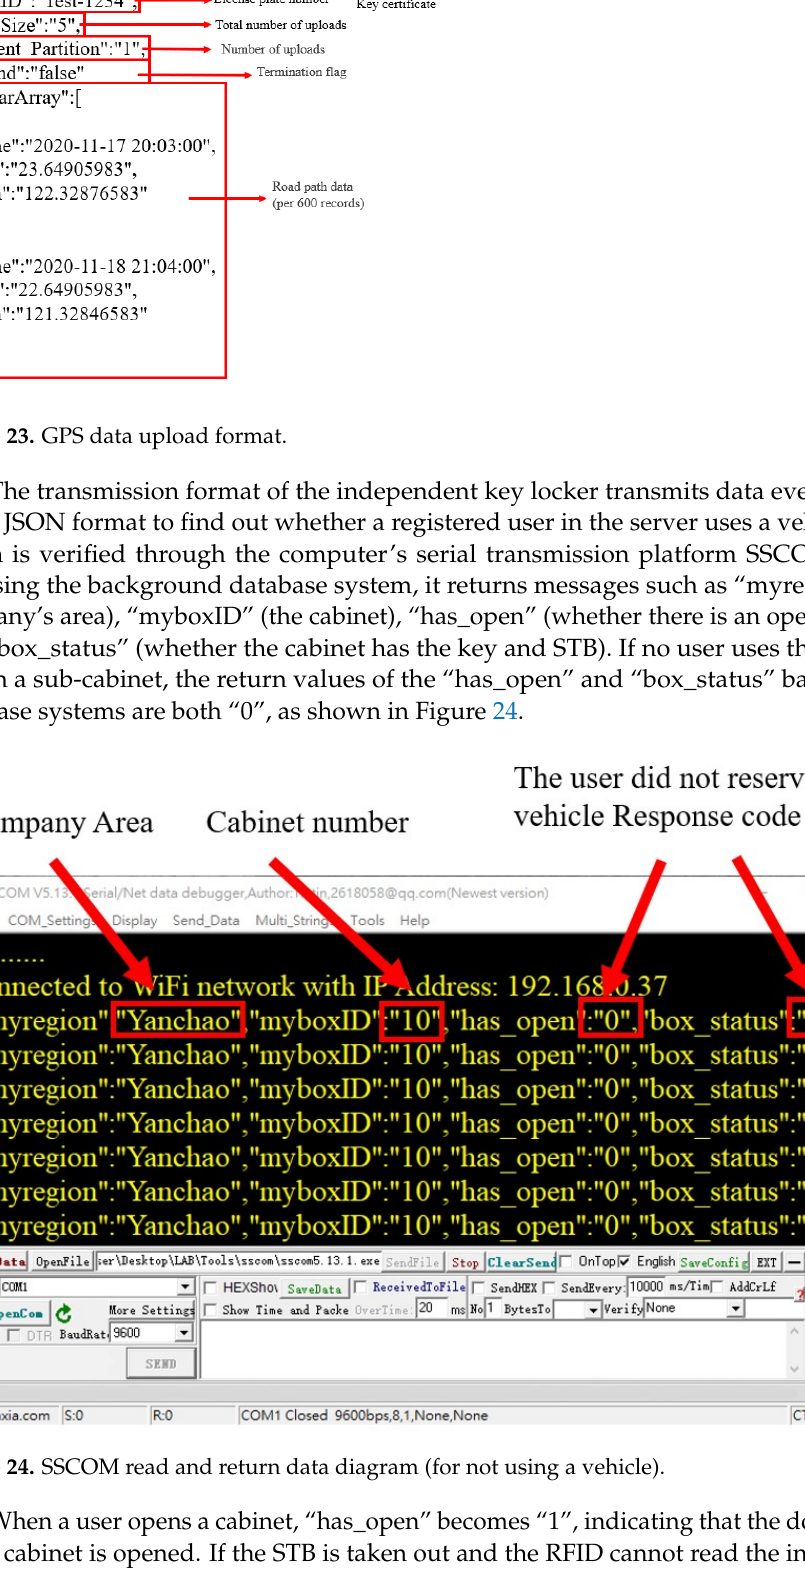
Figure 25. SSCOM read and return data diagram for using a vechicle.